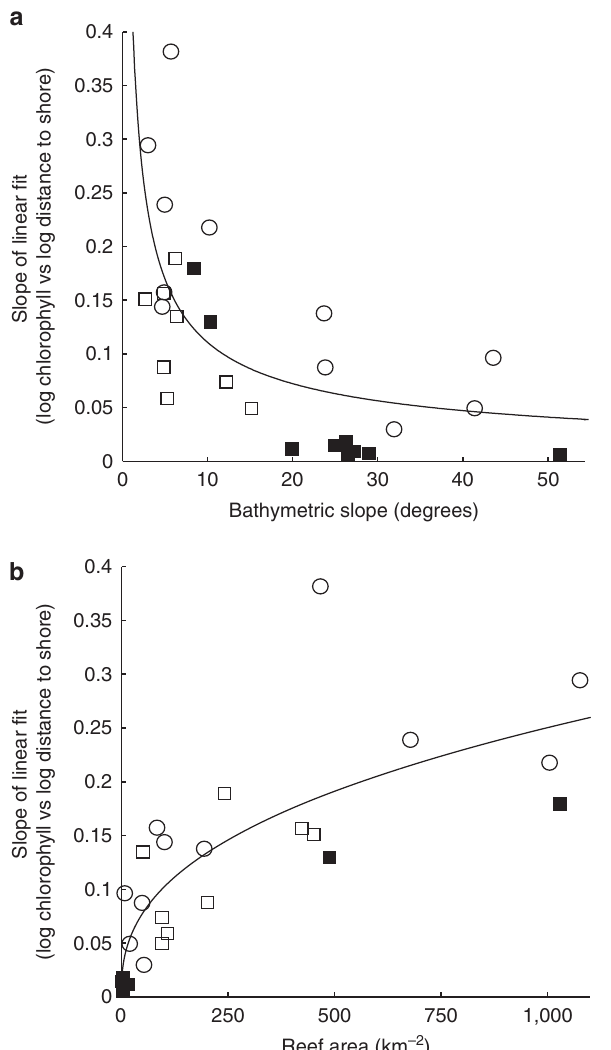
Figure 3 | Biogeophysical drivers of variations in Island Mass Effect strength. Relationship between study locations that had significant phytoplankton biomass enhancement ( y -axis; increasing y represents a greater rate of increase in chlorophyll- a towards shore) and significant drivers identified from model results; bathymetric slope ( a ) and reef area ( b ) with geomorphic type (atolls vs islands, represented as circles vs squares, respectively) and population status (populated vs unpopulated, represented as filled vs open icons, respectively). Geomorphic type and population status are identified the same as in Fig. 2. Nonlinear regressions ( P o 0.05) with r 2 values of 0.45 ( a ) and 0.68 ( b